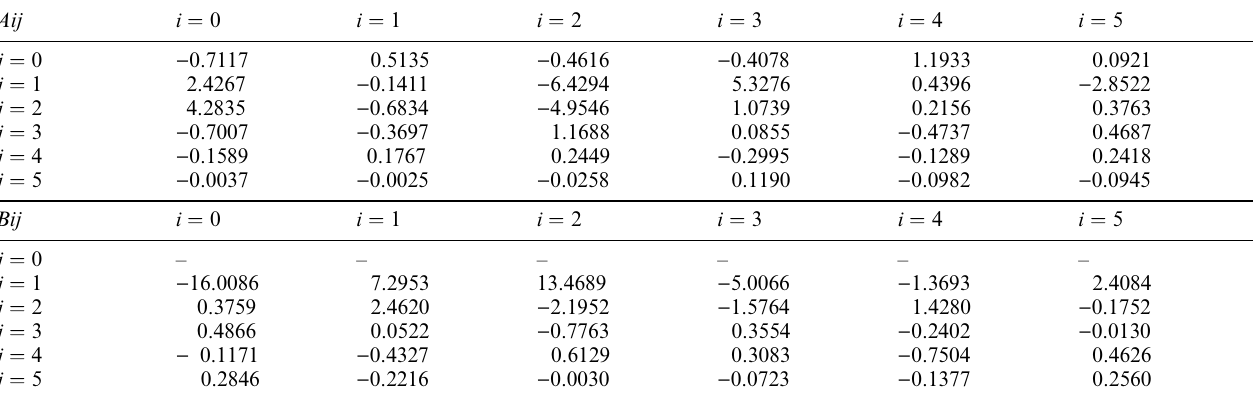
Table 2. Coefficients of the theoretical functions fitting the potential (cid:47) between 63 (cid:176) and 89 (cid:176) invariant latitude for 4 < Kp < 6. Aij